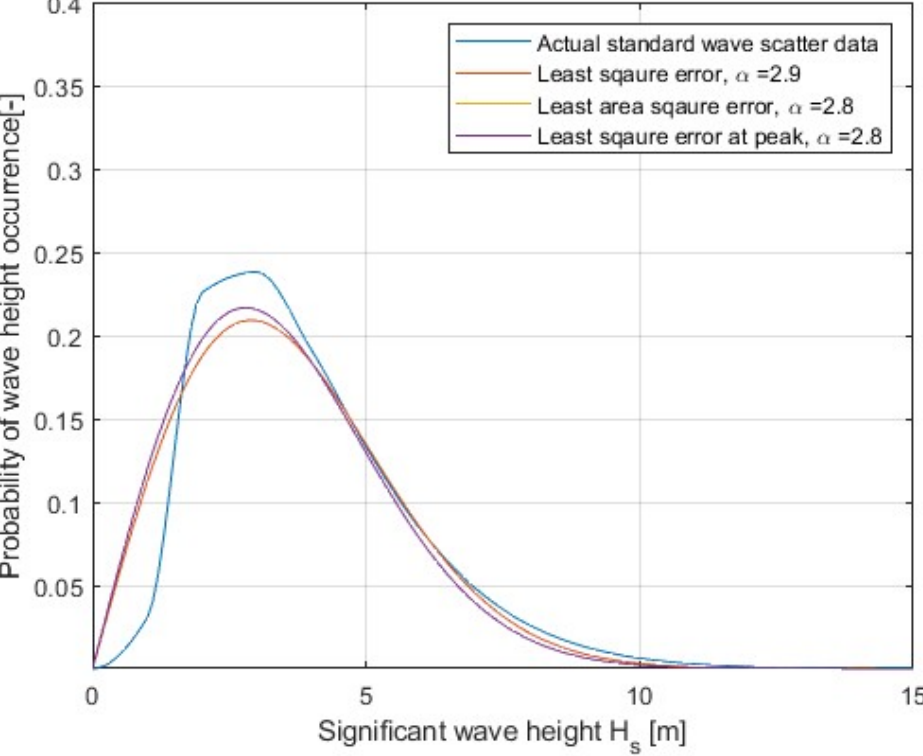
Figure 7. Plots of standard WST pdf.